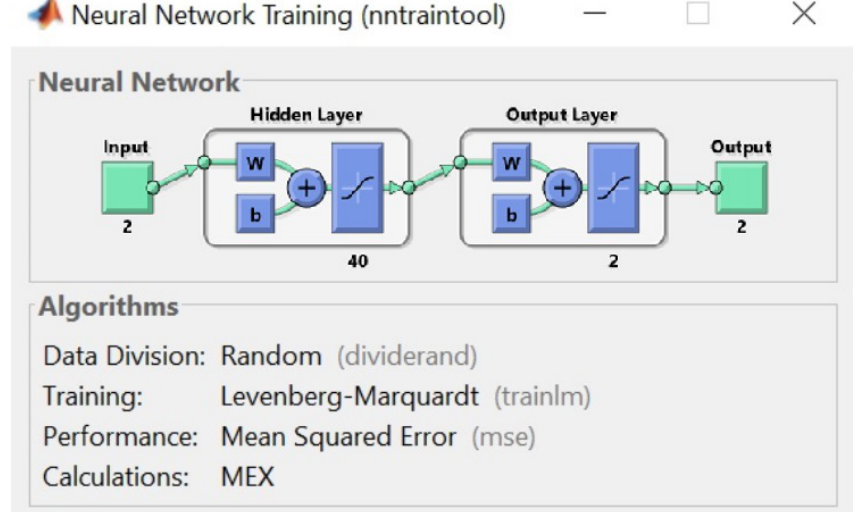
Figure 14. ANN topology for the Quarter Car model optimization. Input layer contains suspension travel and tire deflection population. The output layer contains the designated variables of the optimization, spring rate and damping rate. The hidden layer contains the artificial